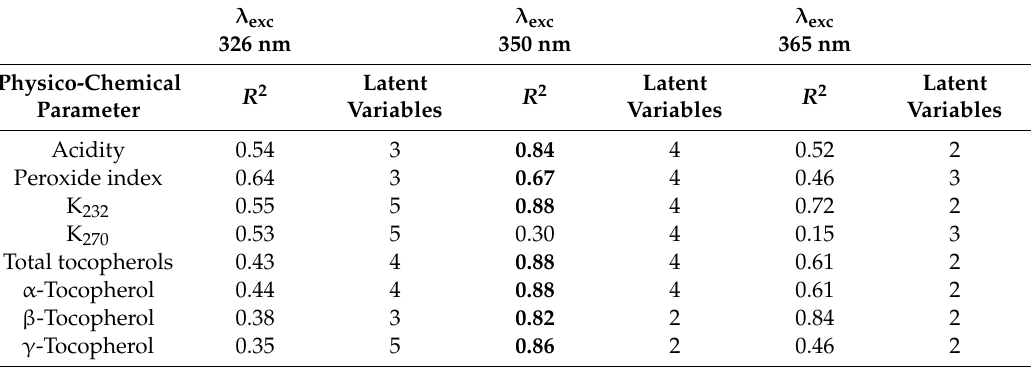
Figure 5. (PLSR) with 4 latent variables for estimation of K 232 with excitation at 350 nm. ( a ) K 232 values determined by the accredited laboratory versus the values estimated with the fluorescence models (colors refer to the three illumination conditions); ( b ) spectra of 5R (green circle) and 4H (red circle) of high and low values of K 232 respectively; ( c ) the two spectra centered with respect to the average of the whole sampling group ( N = 24); ( d ) beta coefficients of the estimation model. Table 6. Result for partial least squares regression (PLSR) models for each physical-chemical parameter. λ